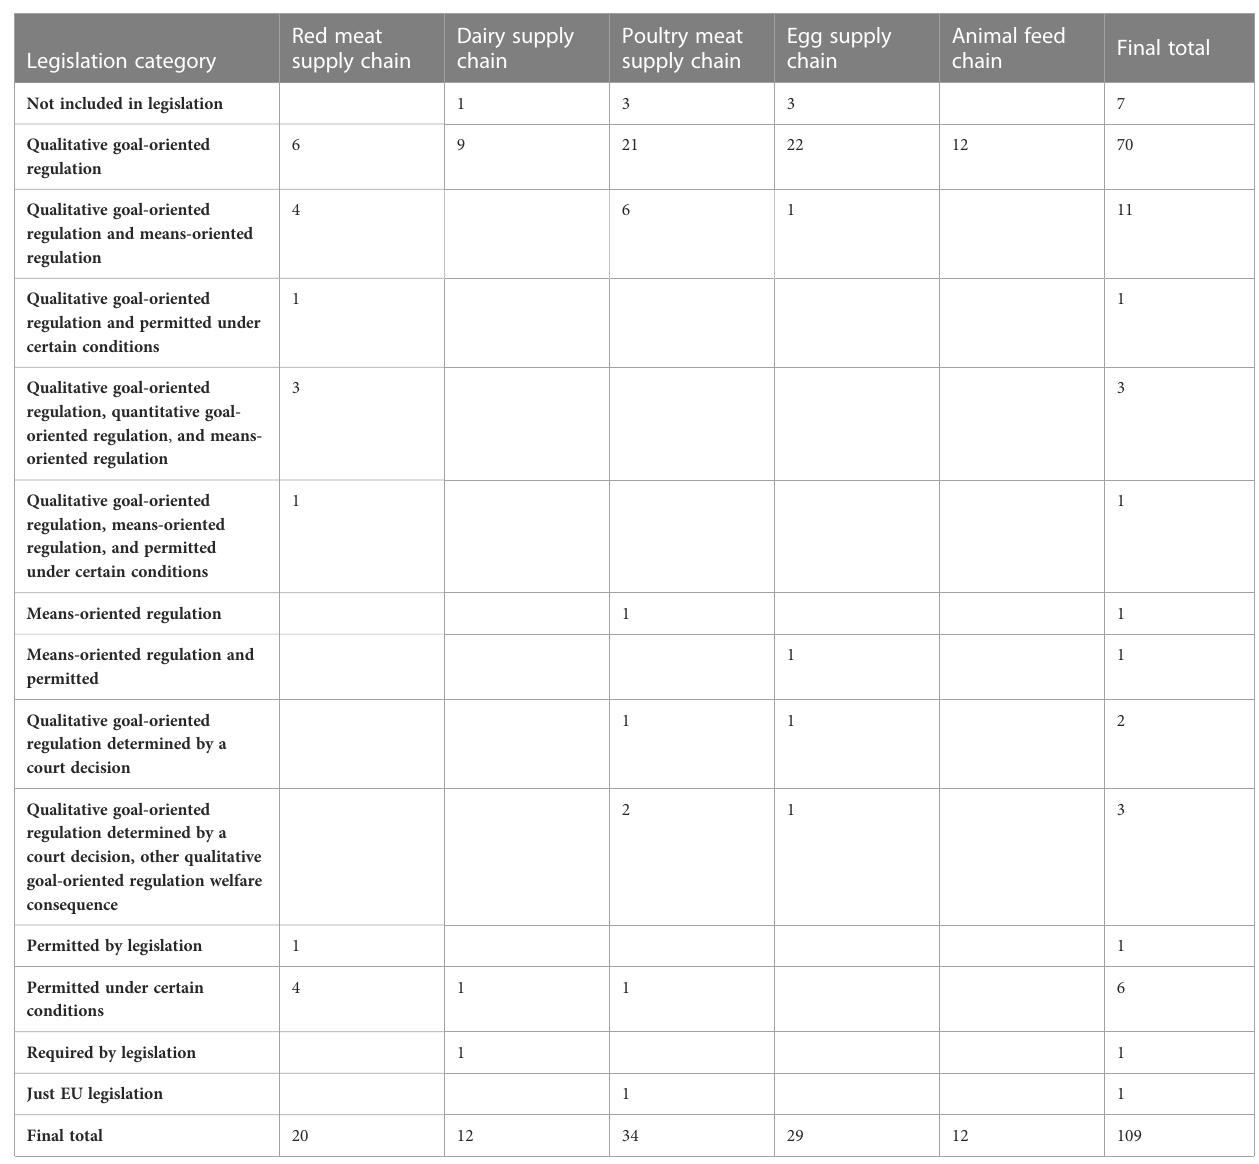
TABLE 4 Number of welfare consequences mentioned in the red meat, dairy, poultry meat, egg, and animal feed supply chains (BuRO, 2015; BuRO, 2017; BuRO, 2019a; BuRO, 2019b; BuRO, 2019c; BuRO, 2019d), categorized by type of legislation and supply